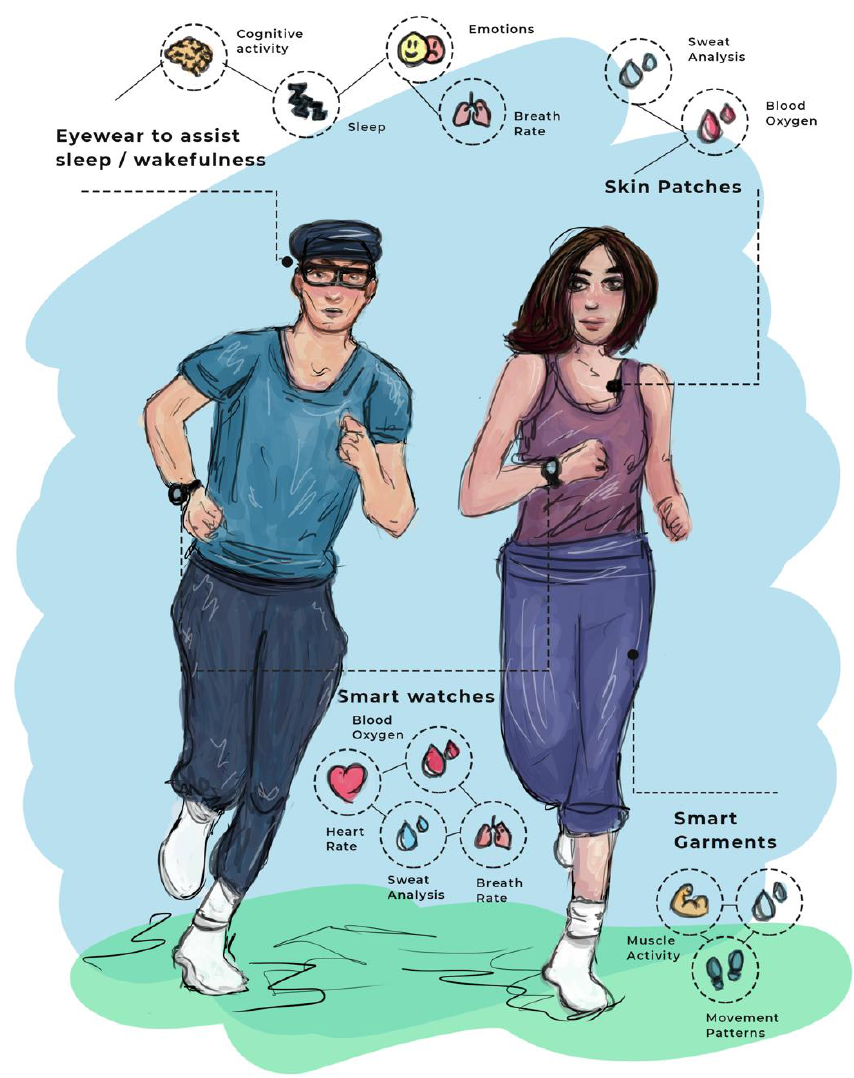
Figure 2. Representation of wearable sensors and detected physiological signs. Table 2. Commercialized wearable sensors to detect physiological signs.